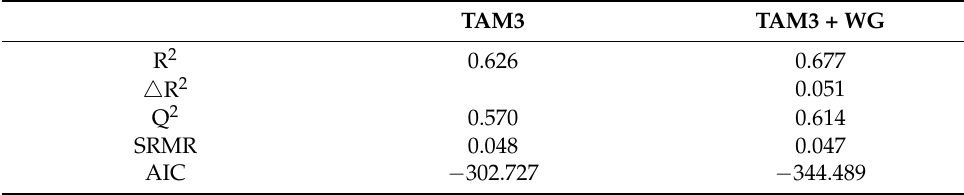
Table 7. Comparison of Models for BI Factor.